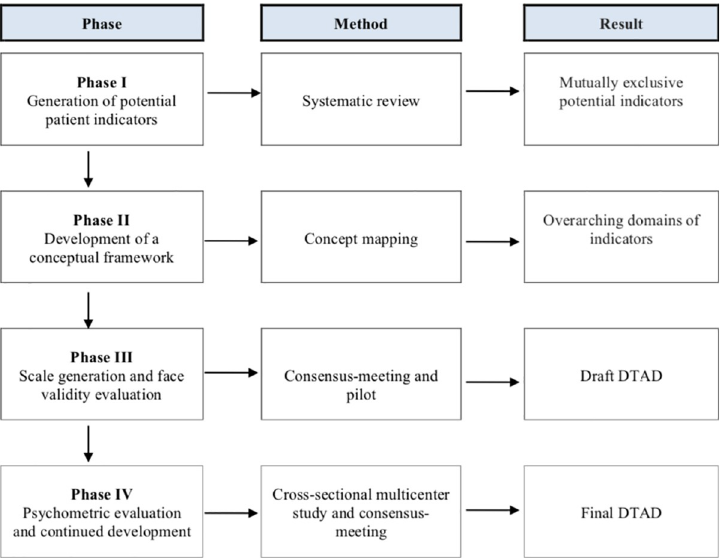
Fig 1. Development of the Decision Tool Anxiety Disorders, OCD and PTSD